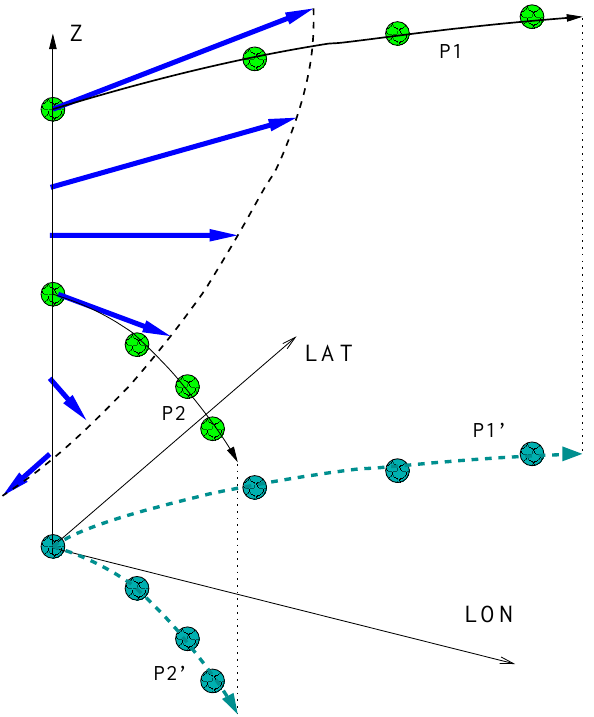
Figure 4. An illustration of the effect of vertical shear on the mean horizontal dispersion of two particles, P1 and P2, initially separated along the vertical